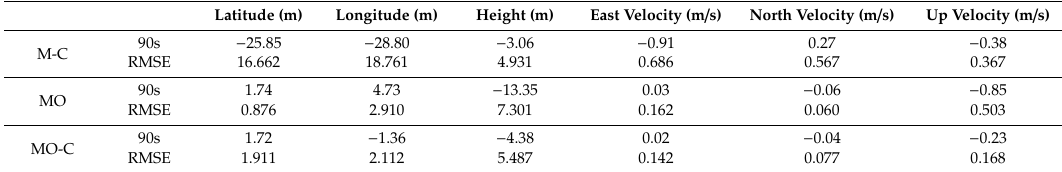
Figure 14. Velocity errors. Table 3. Position and velocity error comparison.